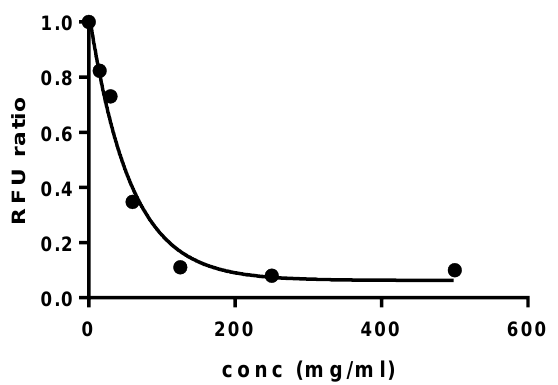
Figure 14. Cell viability of human primary fibroblasts incubated with elosulfase alpha-NLC for 24 h. Results indicated a calculated dosis letal 50 (DL50) value of 56.5 mg/mL. This value was higher than other authors observed for safe auxiliary pharmaceutical substances, such as 2-hydroxypropyl- β-cyclodextrin (DL50 18 m/mL in primary keratocytes, Fernández-Ferreiro A et al [42] ) or Polyethylene glycol 1000 or 2000 (DL50 36.2 mg/mL and 38.2 mg/mL, respectively, in human cervical cancer cells (HeLa) and 22.5 mg/mL and 28.7 mg/mL in fibroblasts derived from mice (L929), Guoqiang Liu et al [43]). Therefore, these data suggested that the viability of human fibroblasts was not negatively affected during co-incubation with elosulfase alpha-loaded NLCs, confirming the cellular compatibility of NLCs with human cells when compared with controls.